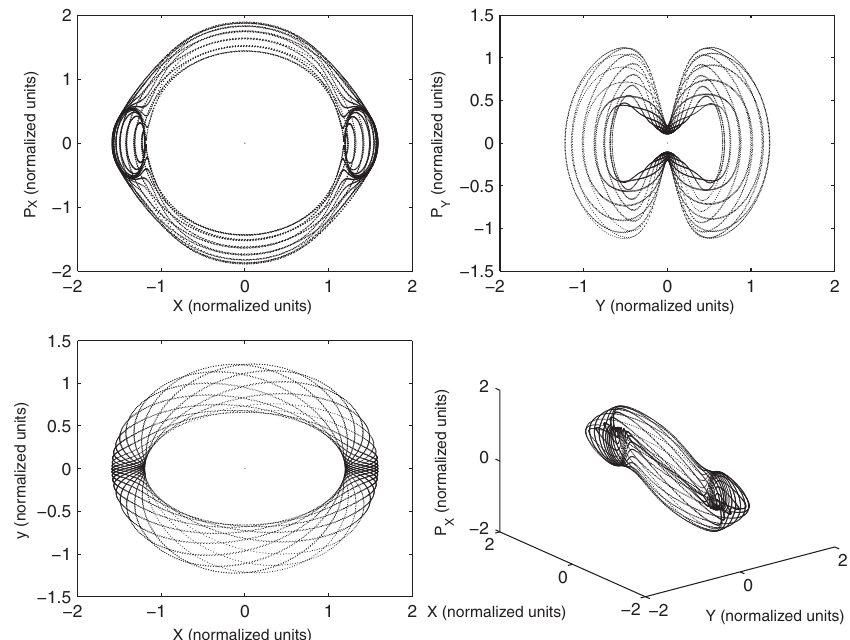
¼ 0 : 1 , y ¼ 0 : 001 , and py ¼ 0 : 2 ( E (cid:3) 3 : 05 and x